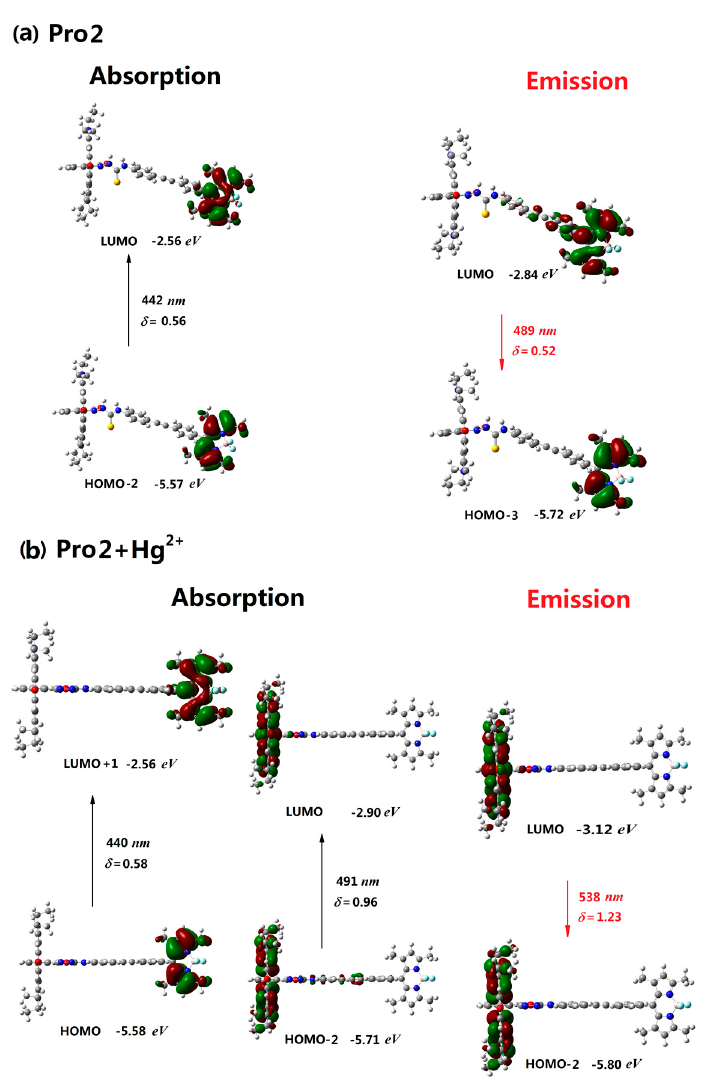
Figure 4. The absorption and emission of ( a ) Pro2 and ( b ) Pro2+Hg 2+ in H 2 O.